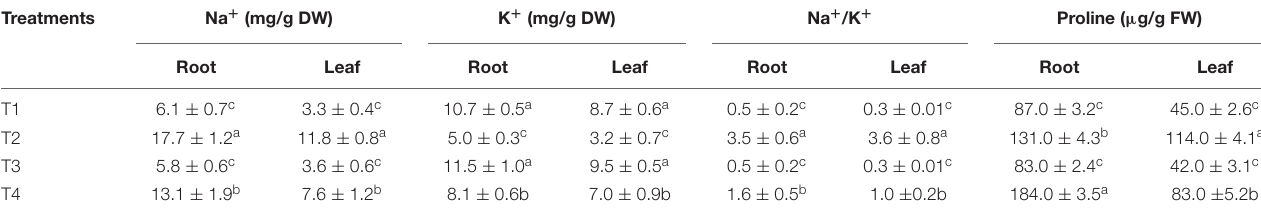
TABLE 3 | Effect of bacterial (BHU-AV3) inoculation on ion and proline content in different tomato plant tissues under salt stress conditions. Treatments